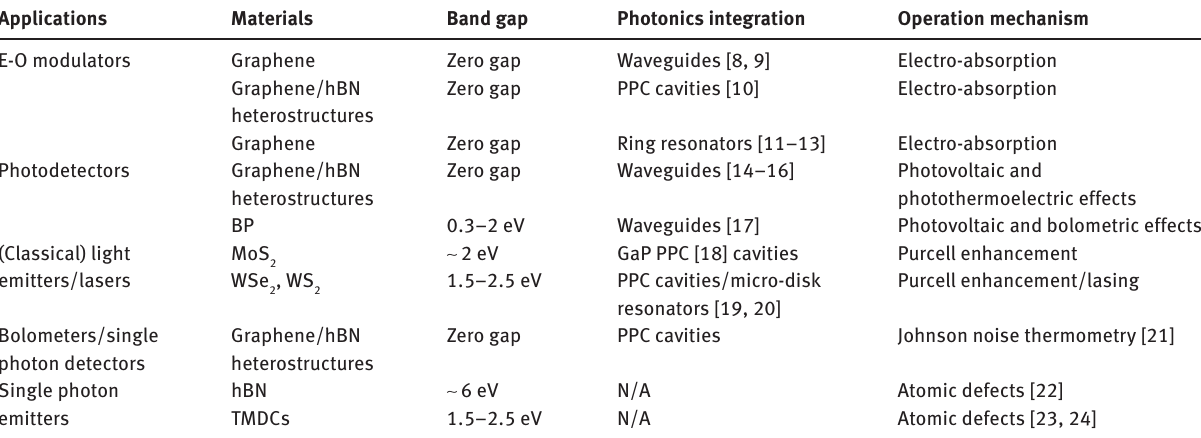
Table 1: List of applications of active nanophotonic and quantum photonic devices based on 2D materials.